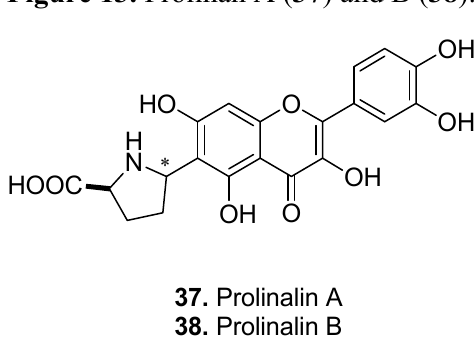
Figure 13. Prolinan A ( 37 ) and B ( 38